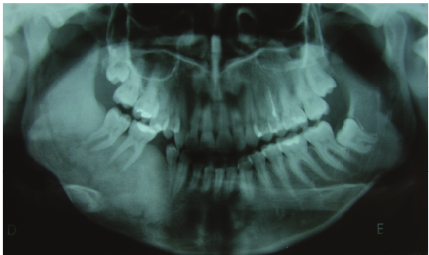
of the image with the appearance of ground glass in the right hemimandible. It can be seen that pieces 4.5 and 4.8 have been